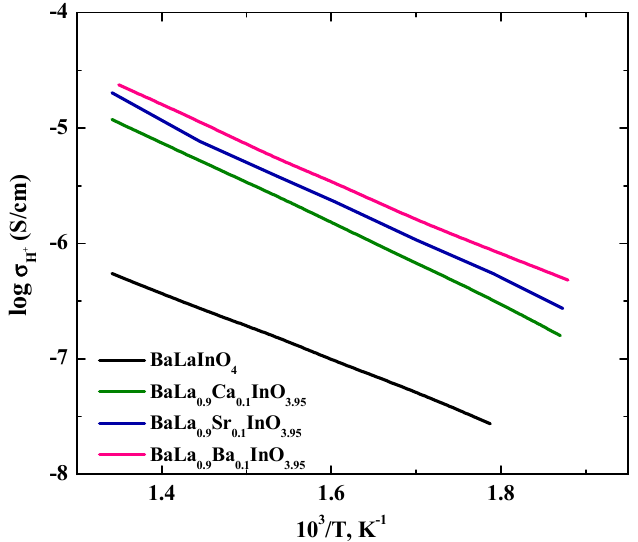
Figure 8. The temperature dependencies of the proton conductivities of BaLaInO 4 and BaLa 0.9 M 0.1 InO 3.95 (M = Ca 2+ , Sr 2+ , and Ba 2+ ).